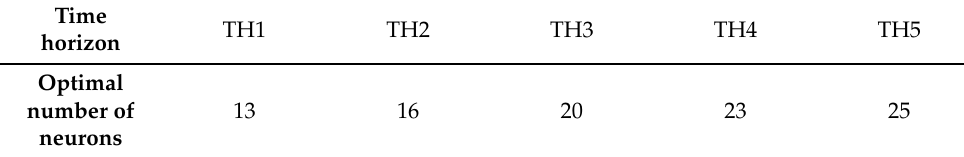
Figure 7. Sensitivity analysis on the number of neurons in the ANN with time horizon equal to 5 min. Table 3. Results of the sensitivity analysis on the ANN hidden layer.